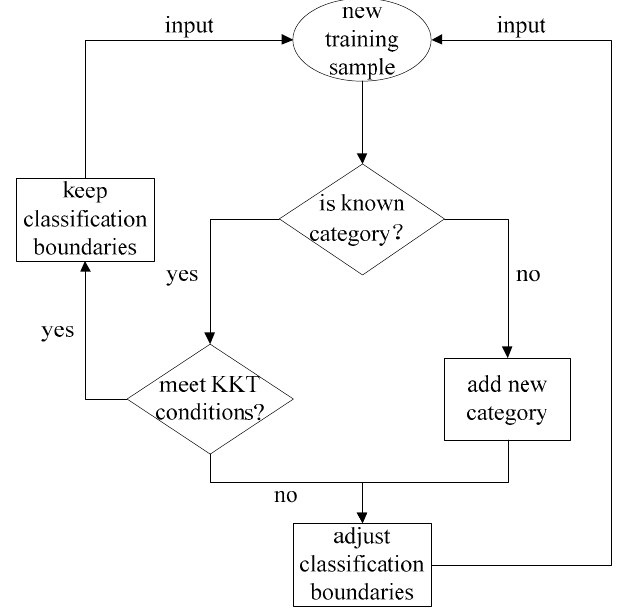
Figure 2. Flow of online learning and updating in radar emitter identification model.